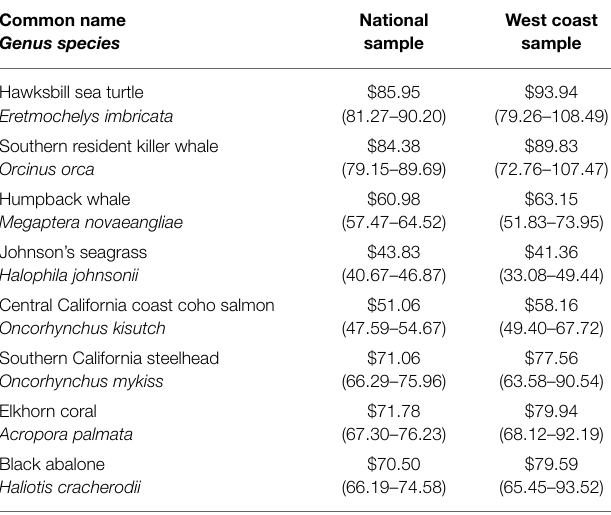
TABLE 6 | WTP * (95% CI) for species recovery for national and west coast